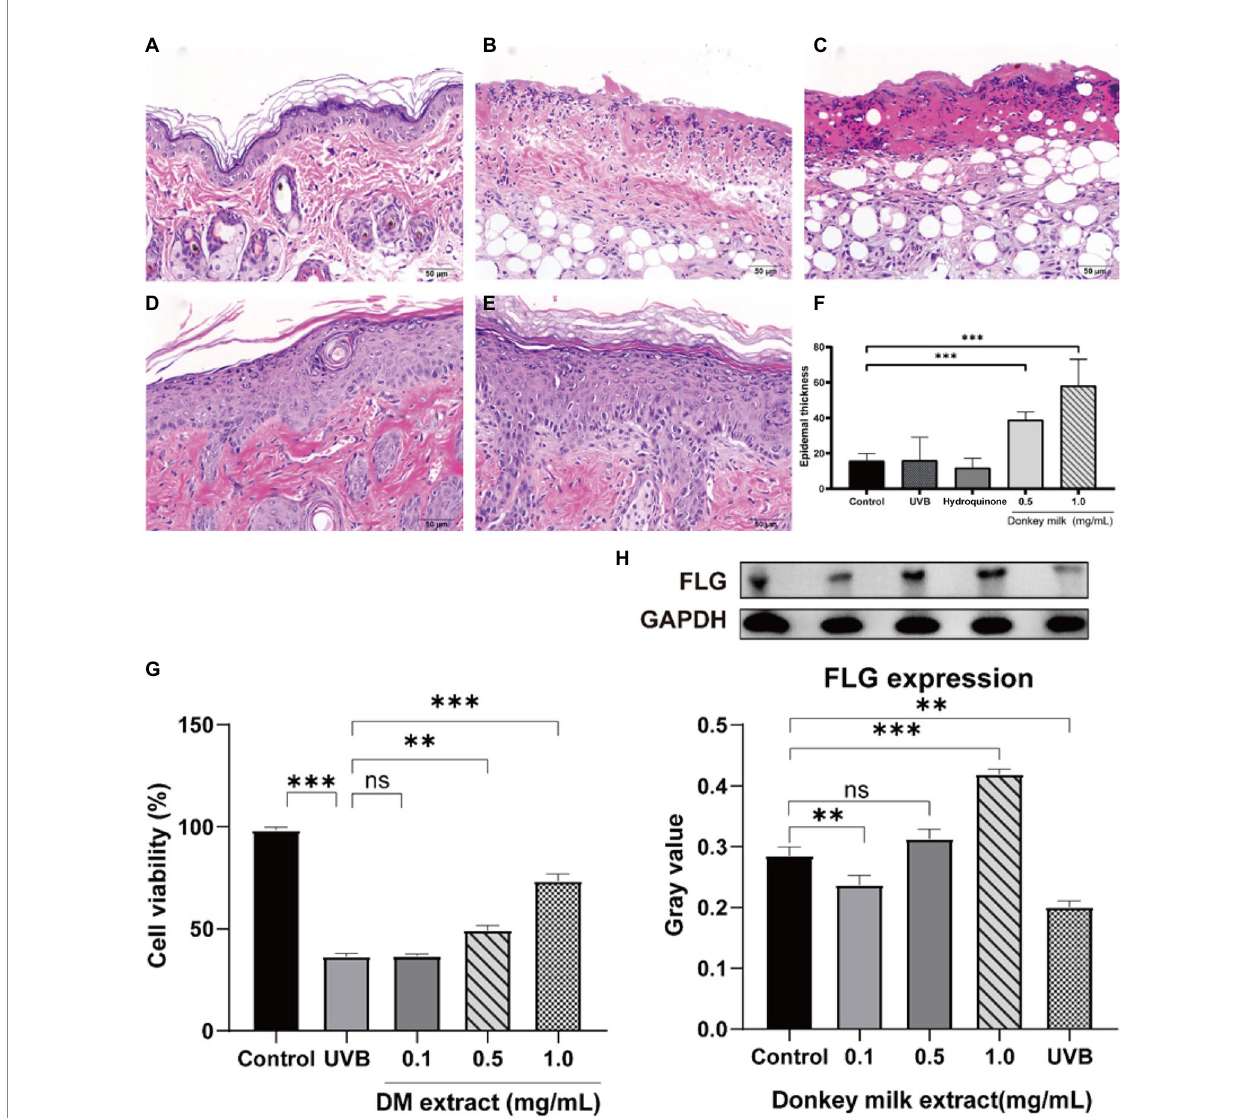
FIGURE 3 Effects of DM on UVB-induced skin barrier damage. The protective effect of DM in mouse through HE staining. (A) Control group. (B) UVB group. (C) Hydroquinone group. (D) 0.5 mg/mL DM group. (E) 1 mg/mL DM group. (F) Epidermal thickness. (G) Effects of DM on HaCaT cell viability after UVB exposure. (H) Effects of DM on expression of FLG in HaCaT cells. The asterisk (** and ***) indicated a significant difference ( p < 0.01 and p < 0.001), the symbol (ns) indicated no significant